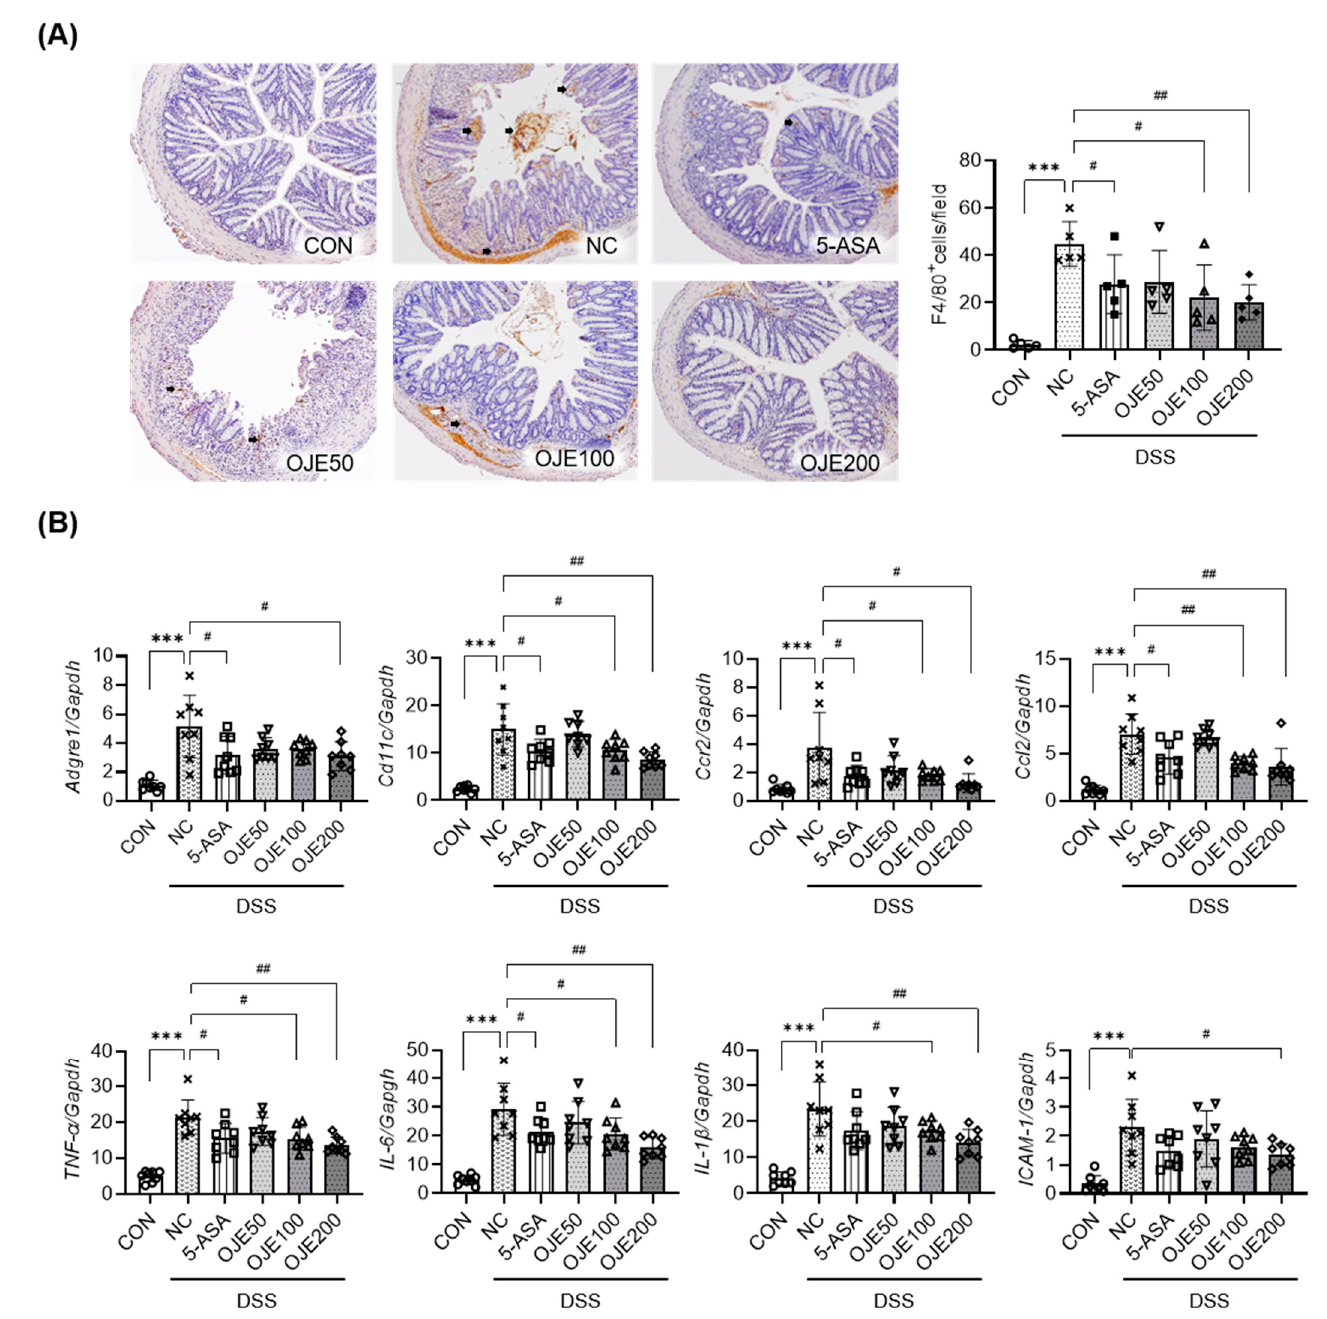
Figure 5. Effects of OJE on inflammation and oxidative stress in mice with DSS–induced colitis. ( A ) After 14 d of DSS treatment, colon tissues were retrieved and subjected to F4/80 immunostaining. F4/80–positive cells were counted (the bar graph shows quantified data derived from five representative animals, n = 5). ( B ) mRNAs of genes related to inflammation in colon tissues were analyzed using qPCR ( n = 8). Values are the mean ± SEM. *** p < 0.001, NC vs. CON; # p < 0.05, and ## p < 0.01, 5-ASA 50 mg/kg, OJE 50 mg/kg, OJE 100 mg/kg, OJE 200 mg/kg vs.